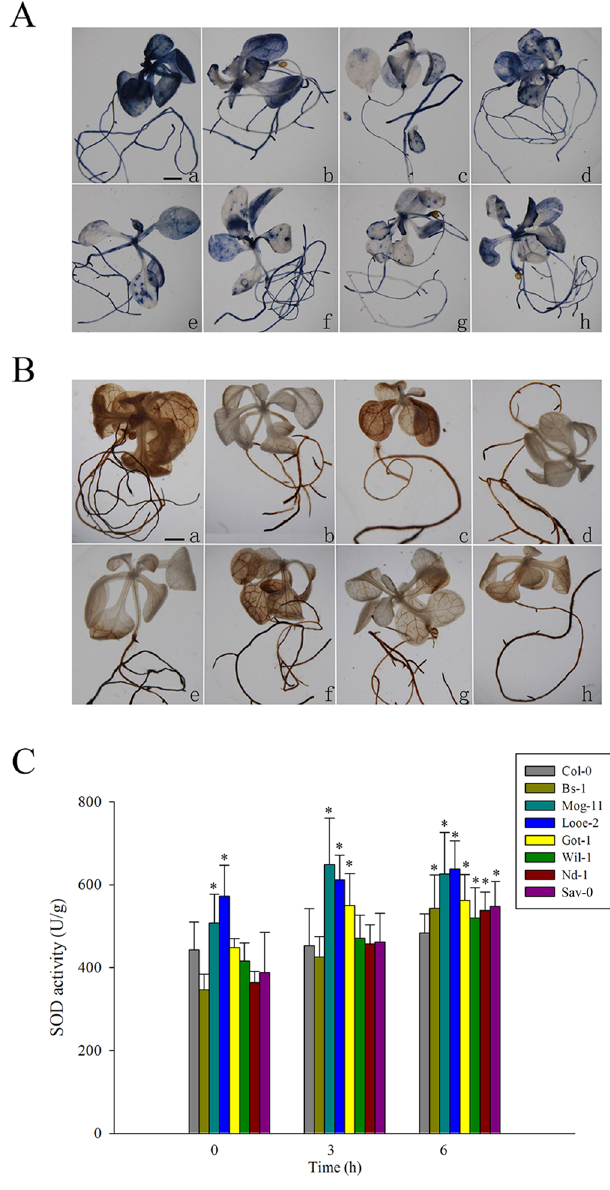
Fig 7. Accumulation of oxidants and superoxide dismutase (SOD) activity in response to salinity stress. (A) Superoxide radical, detected by nitroblue tetrazolium (NBT) staining, (B) H 2 O 2 , detected by 3, 3 ’ - diaminobenzidine (DAB) staining in Col-0 and the selected accessions exposed to 150 mM NaCl for 10 days. a: Col-0; b: Bs-1; c: Mog-11; d: Looe-2; e: Got-1; f: Wil-1; g: Nd-1; h: Sav-0. Bar = 0.1 cm. (C) SOD activity in Col-0 and the selected accessions exposed to 100 mM NaCl for 0, 3 and 9 h. Values given as mean ± SE ( n = 3), each replicate comprised at least 15 seedlings. Significant differences from the performance of Col-0 accession at the same time point are indicated by * ( P <